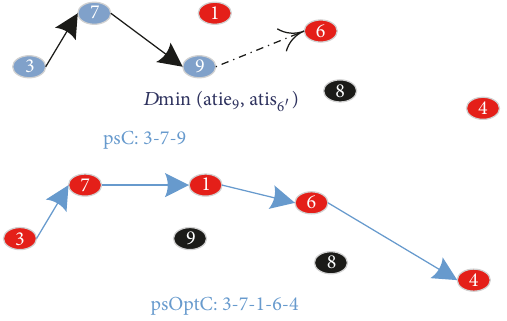
Figure 7: Schematic diagram of the segment replacement based lower bound updating